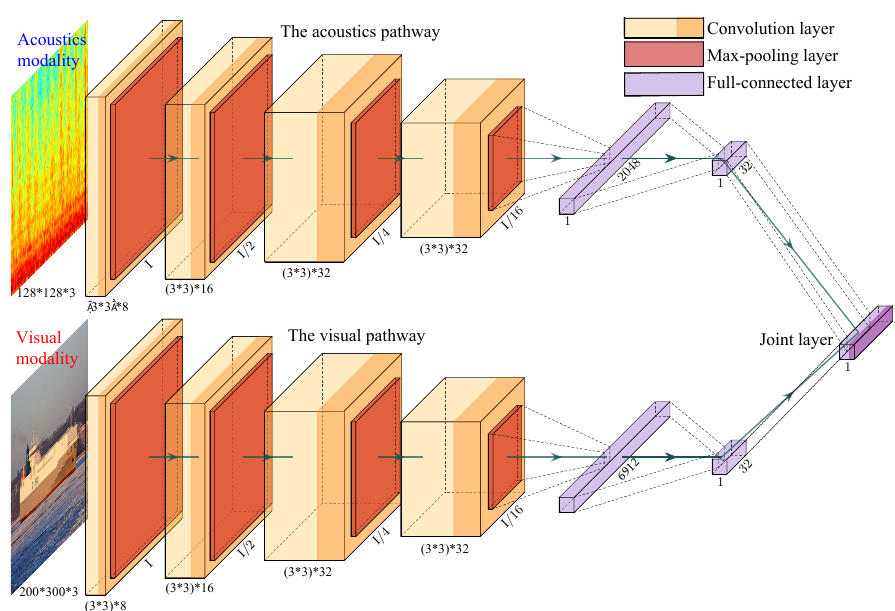
Figure 2. The multimodal convolutional neural networks (multimodal-CNNs) framework for ship-radiated noise